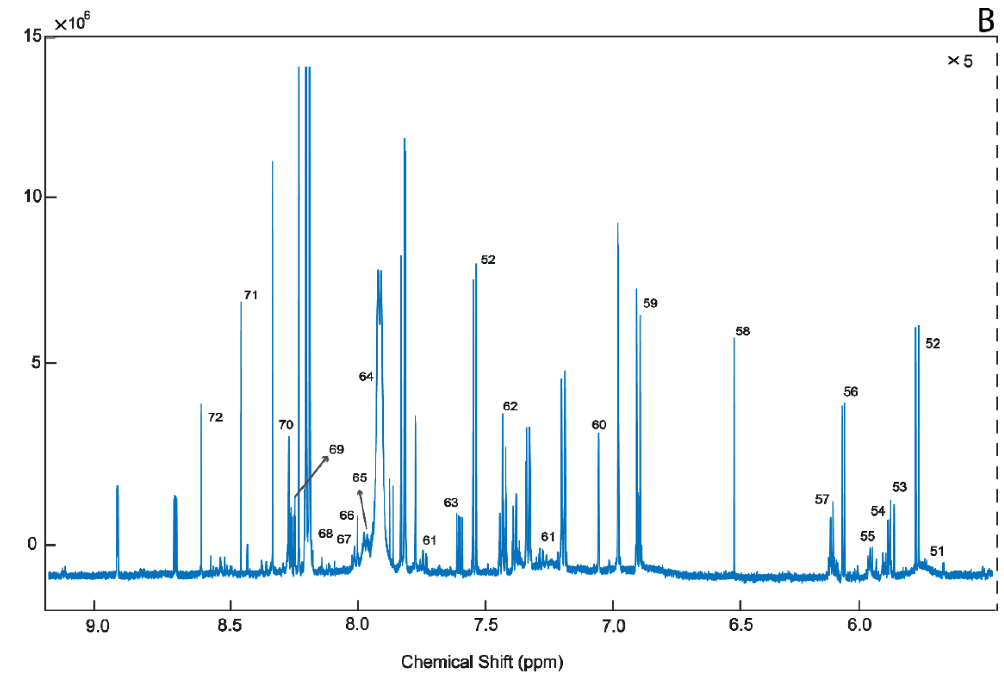
Figure 3. A representative 1D 1H-NMR of PM brain harvested from the BA8 / 46 region from an ENOS sufferer. Aliphatic region covering (0 to 3.0 ppm: A.1 and 3.0 to 5.00 ppm: A.2 ), and five-fold scaled aromatic region ( B ), respectively. 0. Sodium 2,2-dimethyl-2-silapentane-5-sulfonate (DSS) 1.